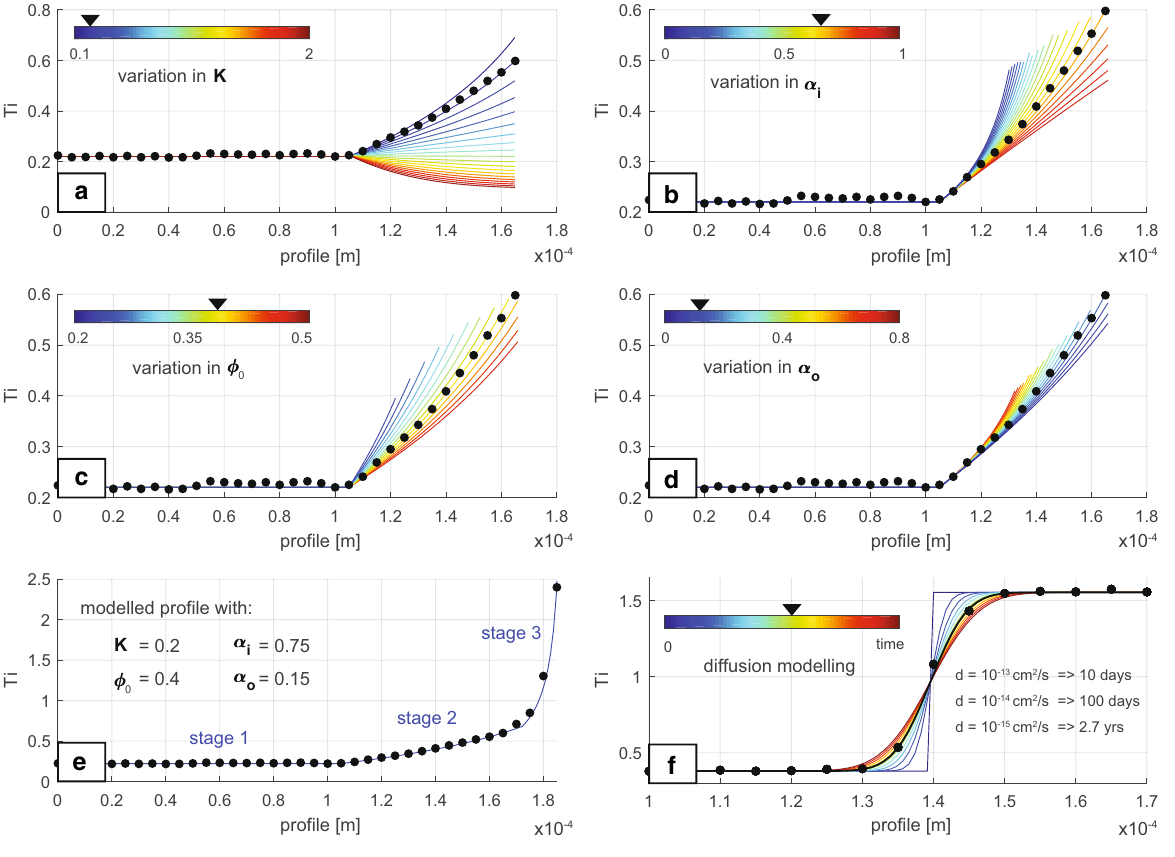
Figure 6. Results of modelling. ( a – d ) Show modelled corundum profiles during stage 2 for a range of partition coefficients ( K ), inflow rates ( v i ), initial melt content ( φ 0 = V l ( 0 )/( R ( 0 ) + V l ( 0 )) ), and outflow rates ( v o ), respectively. Unless stated otherwise, all the models are run using reference values, K = 0.2 ; α i = 0.75 ; φ 0 = 0.4 ; α o = 0.15 . The crystallization rate has been set to v c = 10 − 7 cm/s, following 30 , which implies that the crystallization takes ~ 1 day to complete. ( e ) Comparison between the modelled profile using the reference values and the 5-3 corundum traverse. ( f ) Diffusion modelling of a sharp concentration − 13 ; 10 − 14 ; 10 − 15 gradient using diffusion coefficients, d = 10 cm 2 /s according to 31 . The times representing the best fit for each diffusion coefficient are shown in ( f ), and correspond to the highlighted green line. Other time values for each diffusion coefficient can be inferred relative to these highlighted